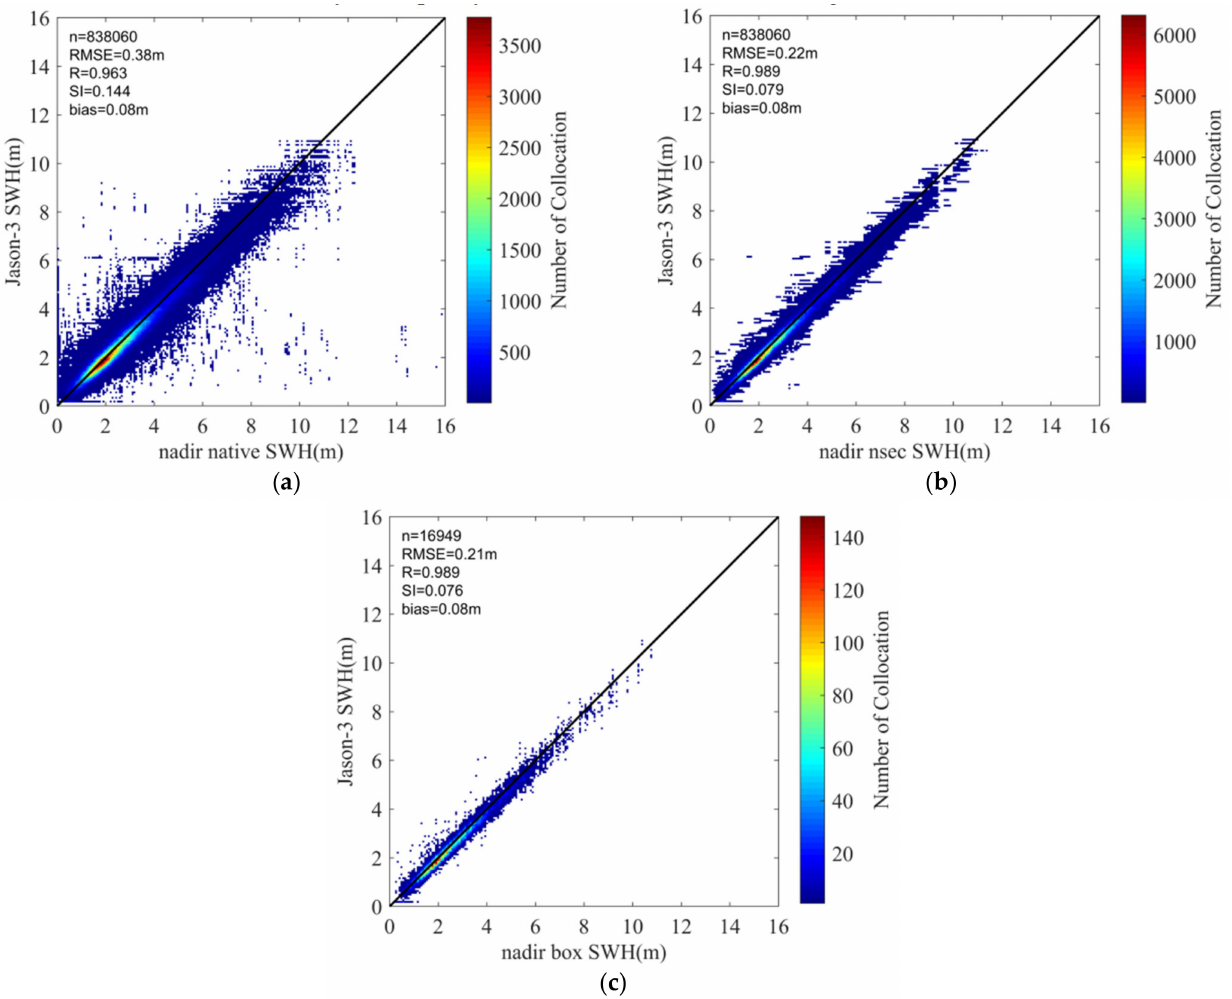
Figure 7. Comparisons between nadir SWH and Jason-3 altimeter data: ( a ) native data, ( b ) nsec data and ( c ) box data. The variation of SWIM nadir box SWH data accuracy with wave height is also evalu- ated by the comparison between nadir SWH and Jason-3 data in the bin of 1 m. The